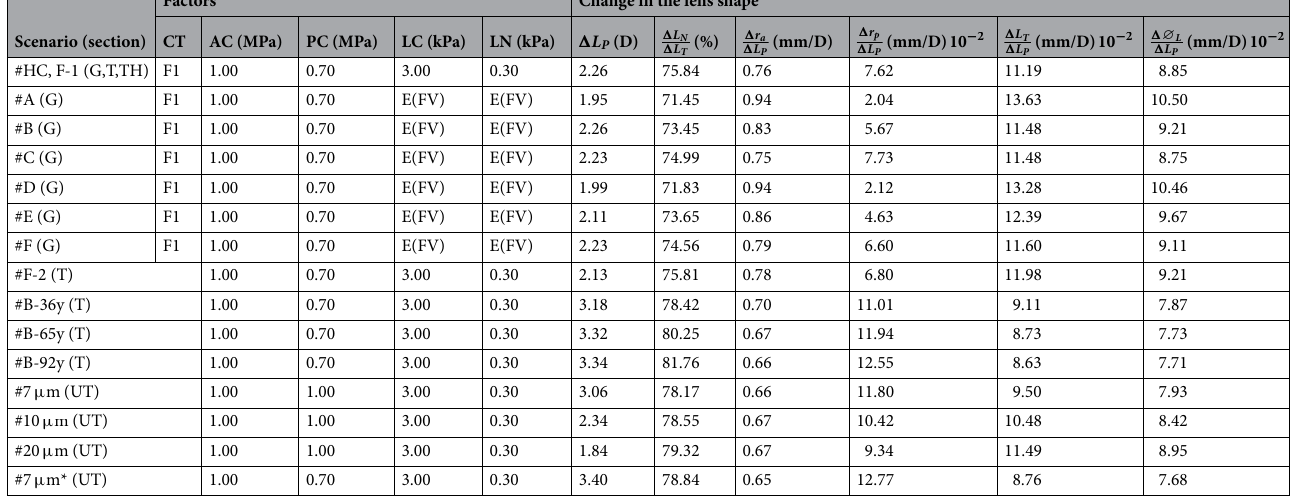
Table 2. The results for the corresponding scenario, together with the corresponding section to which it belongs, gradient (G), thickness (T) or uniform thickness (UT), is described. The corresponding factor for each scenario is described: the distribution of the capsule thickness (CT) for the gradient section. In turn, the section thickness describes itself, as do the Young’s modulus values of the anterior capsule (AC), posterior capsule (PC), lens cortex (LC) and lens nucleus (LN). Furthermore, the registered lens biometric measurements are presented: the maximum change in lens power ( (cid:31) L P ), the variation in the lens thickness of (cid:31) r p (cid:31) L T (cid:31) ∅ L the nucleus ( (cid:31) L N (cid:31) L ) and the following ratios: (cid:31) r a (cid:31) L , (cid:31) L P , (cid:31) L P , and (cid:31) L P P T